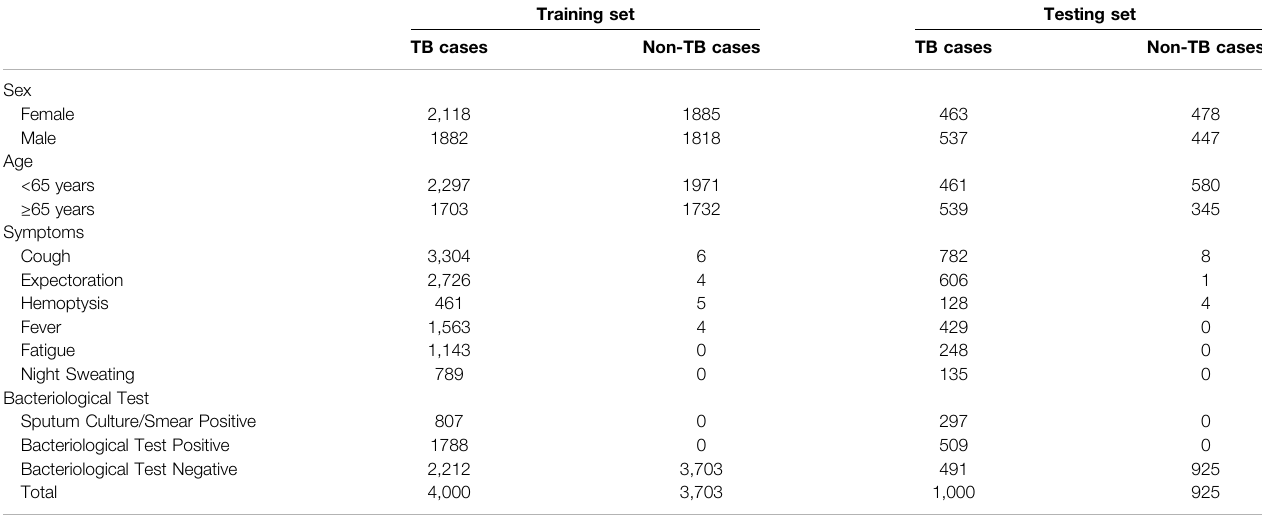
TABLE 1 | A summary of clinical characteristics of training and testing